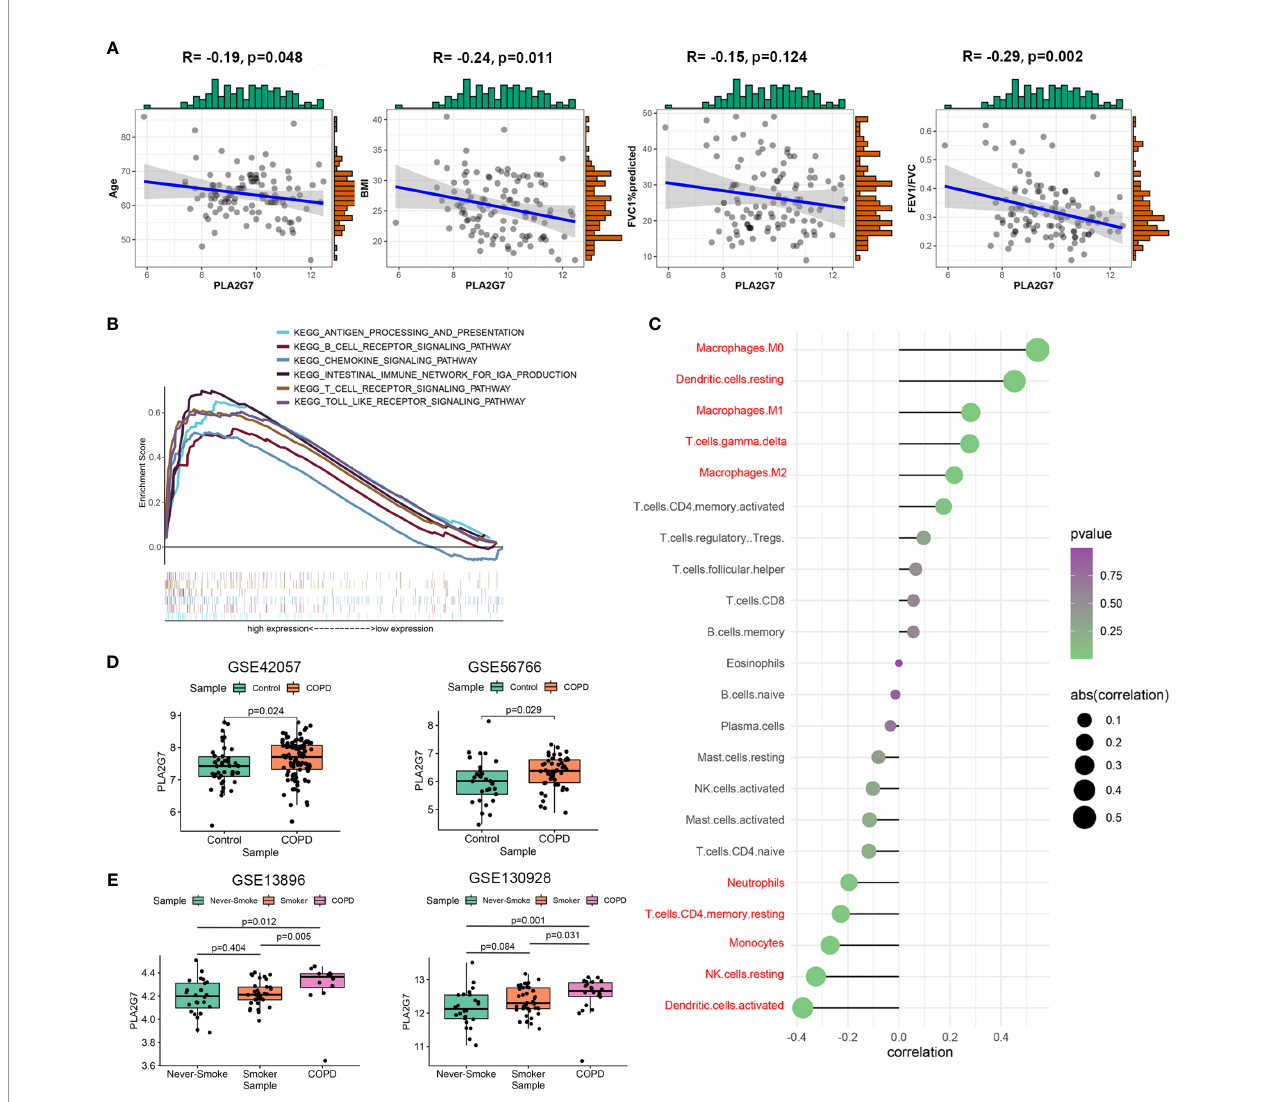
FIGURE 5 | Function analysis and validation of PLA2G7. (A) The relationship between PLA2G7 and the clinical characteristics (age, BMI, FVC%predicted and FEV1/ FVC) of COPD patients; (B) GSEA results showed that several immune-related pathways were signi fi cantly associated with PLA2G7; (C) Relationship between PLA2G7 expression and immune cell in fi ltration level; red: statistically signi fi cant (P < 0.05); (D) PLA2G7 expression was increased in blood of COPD patients based on GSE42057 (left) and GSE56766 (right); (E) PLA2G7 expression were up-regulated in alveolar macrophages of COPD samples based on GSE130928 (left) and GSE13896